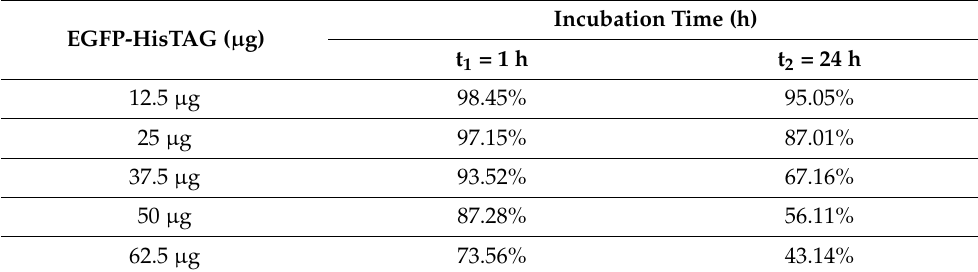
Table 1. Nickel (II) alginate binding capacity of EGFP-HisTAG over two incubation